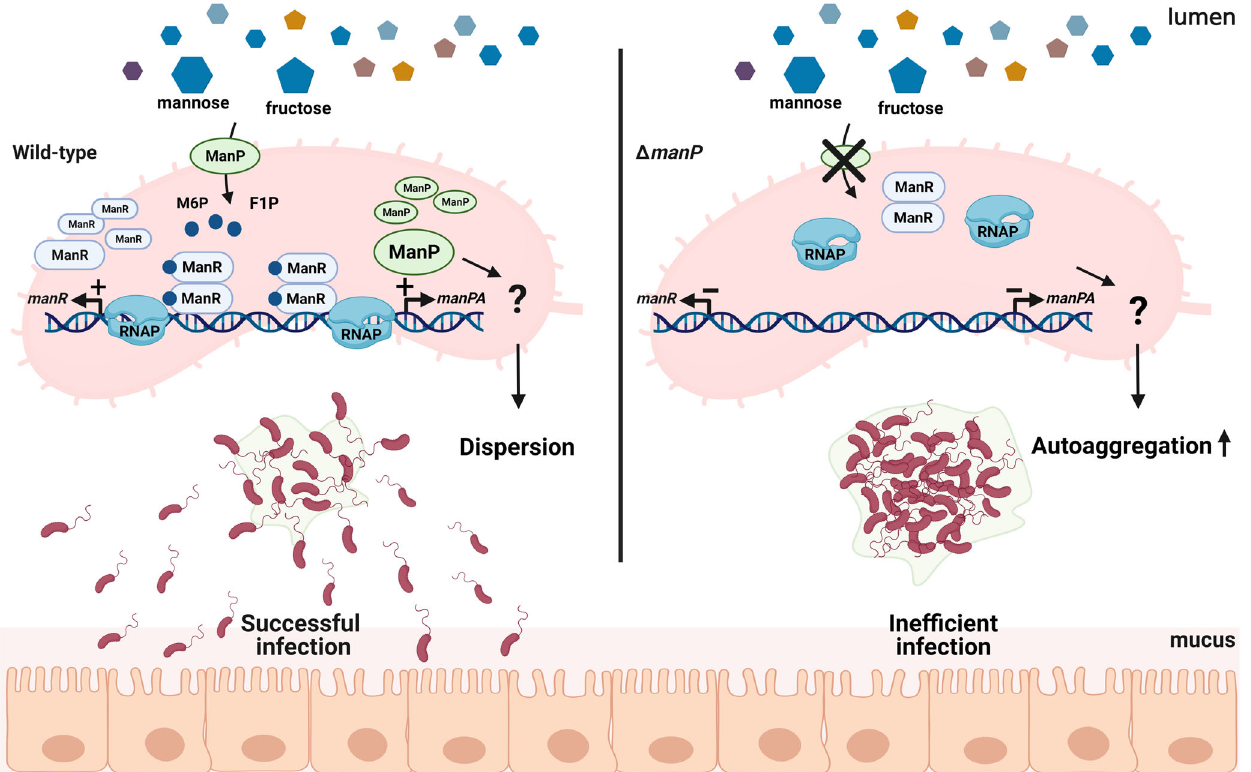
Fig. 8 A schematic diagram of the hypothesis for the regulation of bio fi lm formation by ManR. In the early infection stage, V. cholerae senses mannose and fructose in the intestinal lumen and transports them as M6P and F1P, respectively, via ManP. Upon binding to intracellular M6P or F1P, ManR activates the transcription of its regulon genes, including the mannose operon. As manP expression increases, bacterial cells will take up more mannose and fructose, constituting a feedforward loop. Because ManP suppresses autoaggregation (through a mechanism yet to be understood, marked with ?), V. cholerae cells can disperse more ef fi ciently without bio fi lm formation, thus can colonize, proliferate, and spread in the host intestine. However, when manP is not expressed, cell-cell aggregation is induced, which prevents successful infection. Illustration created using